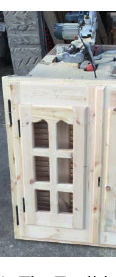
Fig. 1. The Traditional ‘Sheesh